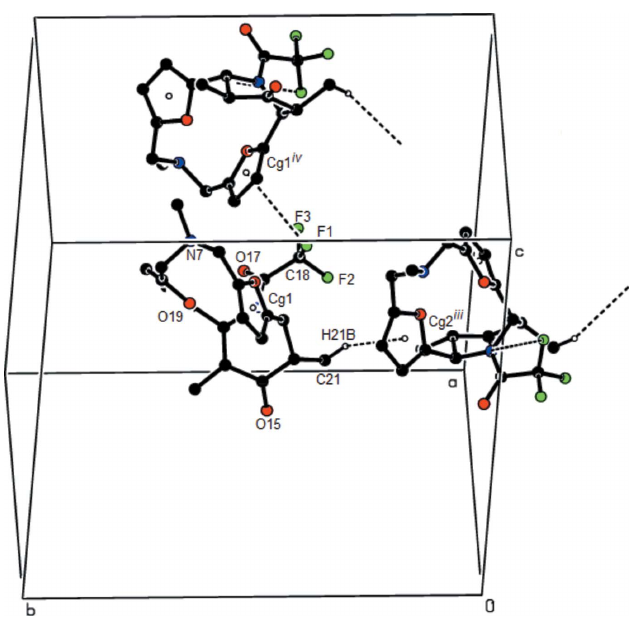
Figure 4 A general view in the unit cell of the C—H (cid:3)(cid:3)(cid:3) (cid:2) and C—F (cid:3)(cid:3)(cid:3) (cid:2) interactions (dashed lines). Symmetry codes: (iii) (cid:4) x + 1 294